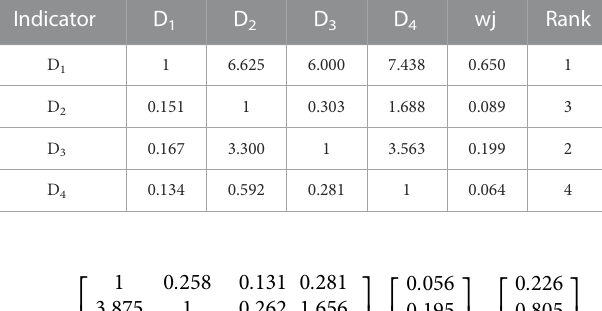
TABLE 16 Pairwise comparison matrix of construction preparation factor layer (AHP). Indicator